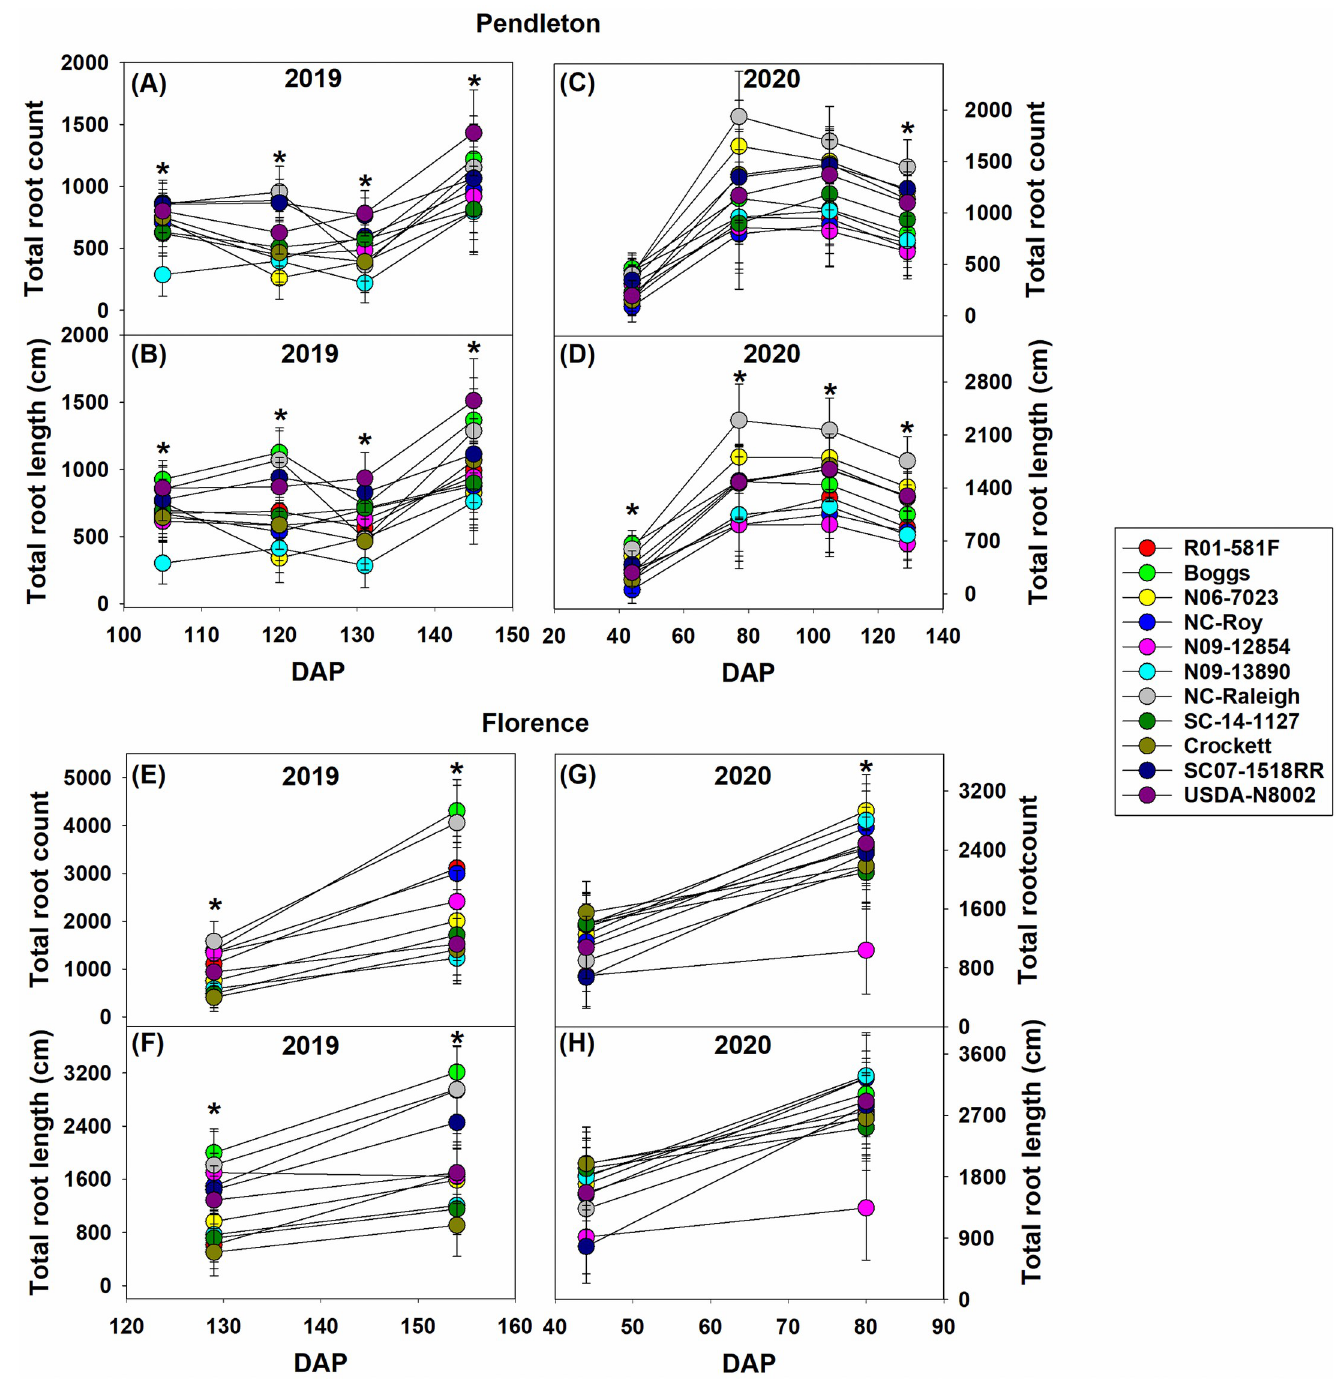
Fig 7. Changes in total root count and total root length of the soybean genotypes in 2019 and 2020 at Pendleton and Florence. Asterisk shows differences among genotypes based on the Fisher’s least significant difference (LSD) test at α = 0.05. DAP–days after planting. Total root count is the total number of roots visible in the imaging area of the CI-602 root imager. Total root length is the sum of the lengths of all roots visible in the imaging area of the CI-602 root imager. Most genotypes reached R1 or R2 growth stage by 105 DAP, R4 growth stage by 120 DAP, R5 or R6 growth stage by 131 DAP, and R7 or R8 growth stage by 145 DAP at Pendleton in 2019. Most genotypes reached V7, R4, R5, and R6 growth stages by 44, 77, 105, 129 DAP, respectively, at Pendleton in 2020. Most genotypes reached R6 growth stages by 129 DAP and R7 or R8 growth stage by 154 DAP at Florence in 2019. Most genotypes reached V7 and R4 growth stages by 44 and 80 DAP, respectively, at Florence in 2020. Growth stages were determined following Fehr and Caviness